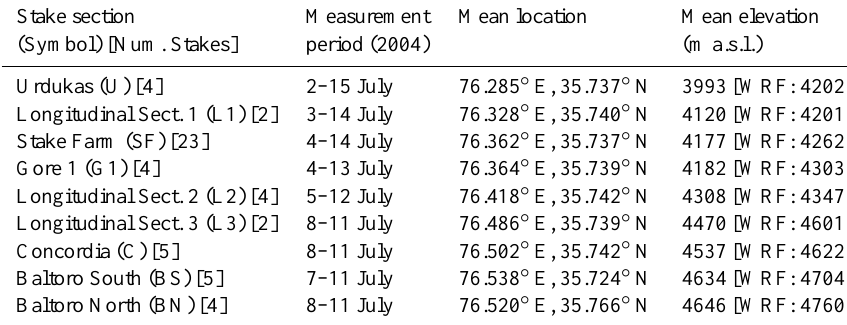
Table 3. Summary of available ablation stake measurements from the Baltoro glacier. Stake section Measurement Mean